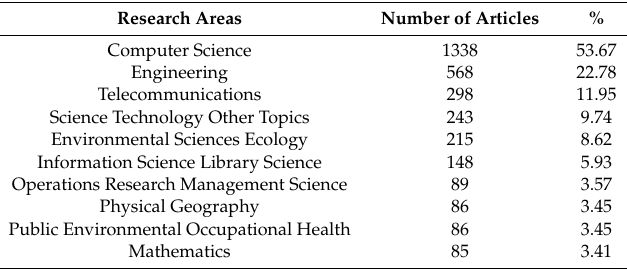
Table 1. Top 10 research areas by number of articles.